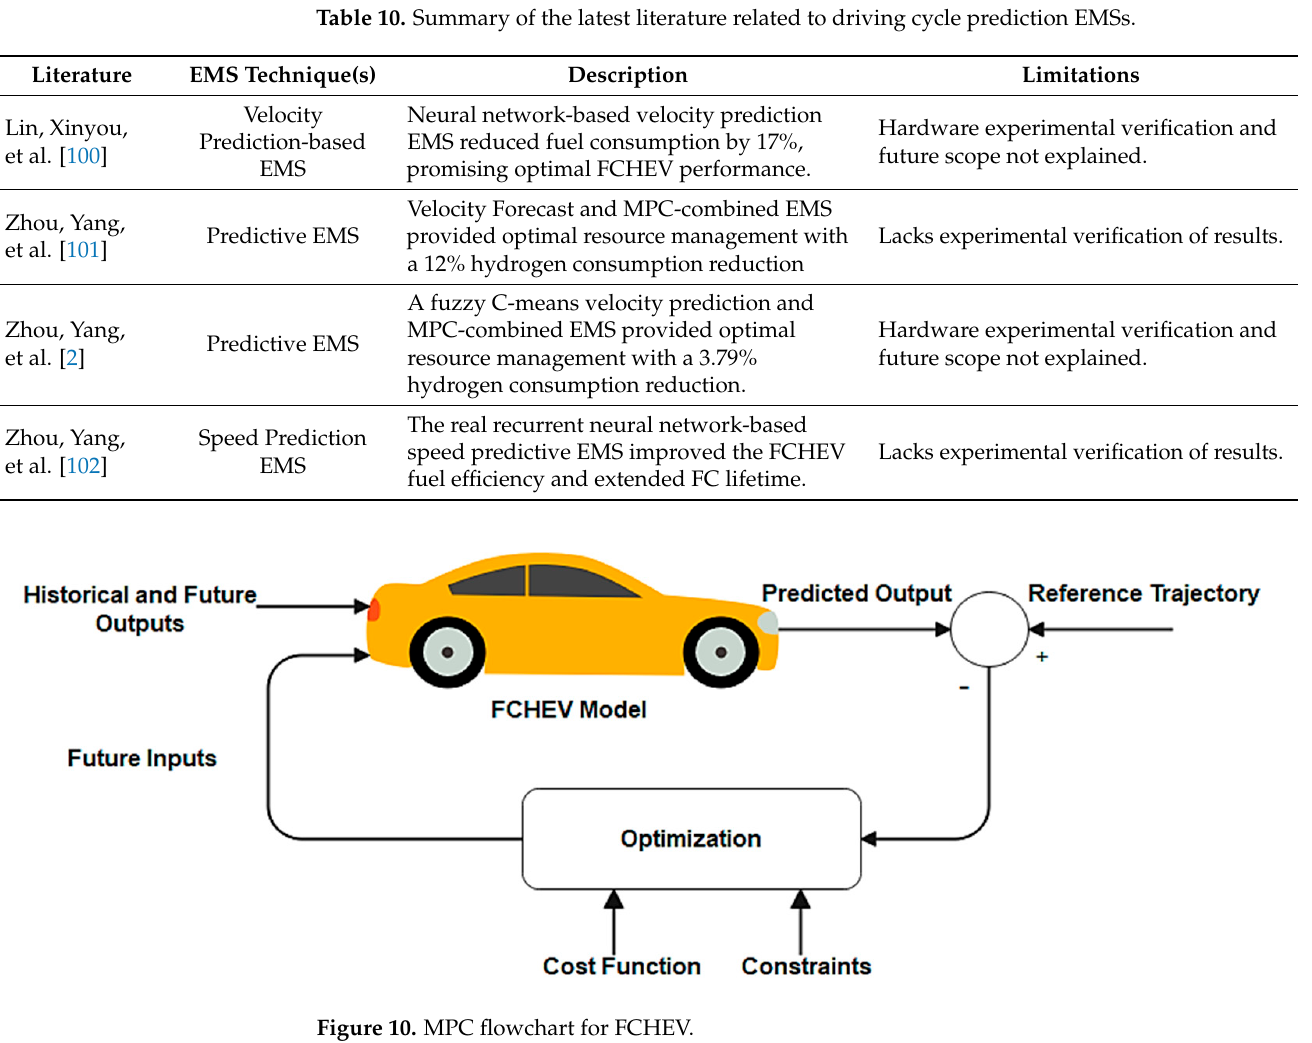
Figure 10. MPC fl owchart for FCHEV. Figure 10. MPC flowchart for